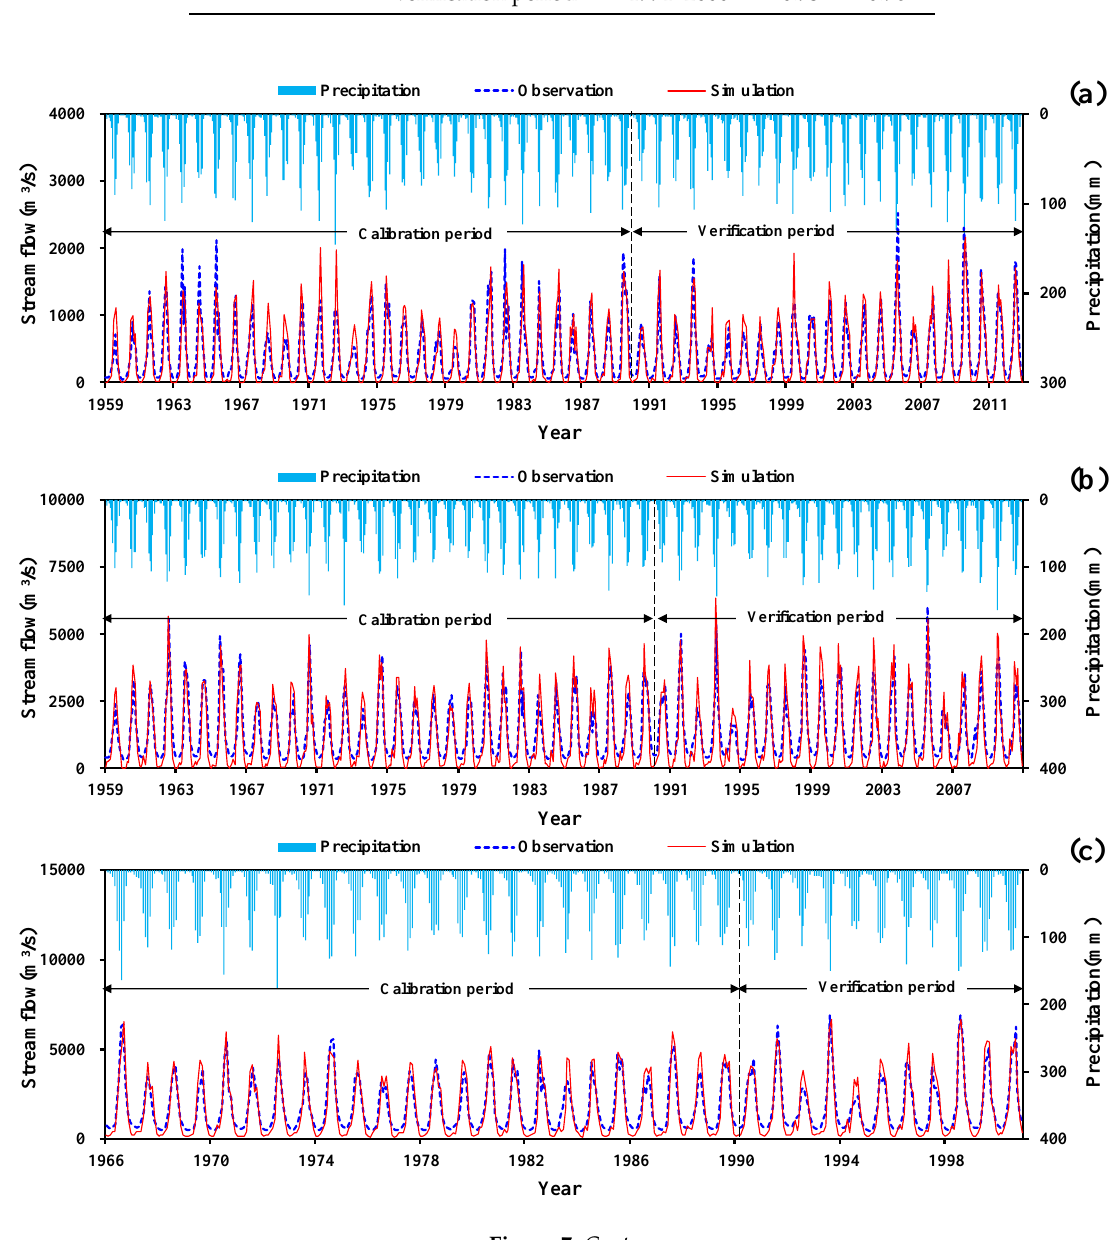
Figure 7. Simulated and observed monthly discharge during the calibration period and the verification period: ( a ) Zhimenda catchment; ( b ) Shigu catchment; ( c ) Panzhihua catchment; ( d ) Huatan catchment. 3.2. Sensitivity of Streamflow to Climate Change With the output of the SWAT using hypothetical climate scenarios, the sensitivity of runoff to climate change was estimated by Equation (5). Then the response of streamflow to changes of precipitation and temperature can be analyzed (shown in Figures 8 and 9). In general, a rise in temperature would be a negative impact in streamflow due to higher evaporation and an increase in precipitation would certainly lead to higher streamflow.